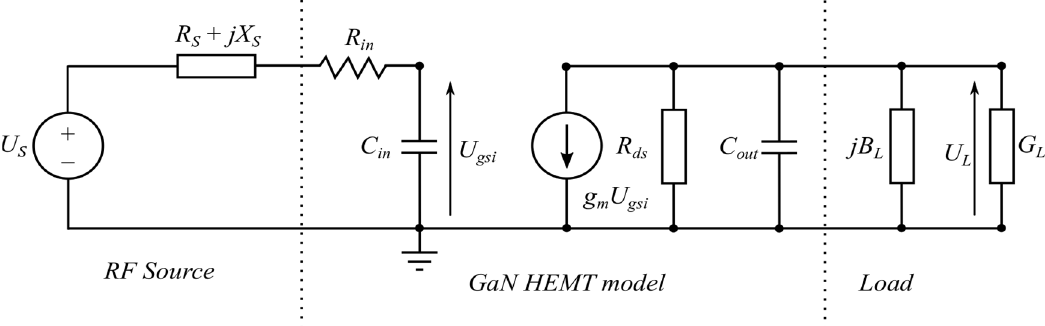
Figure 2. Amplifier model simplified by the Miller theorem.